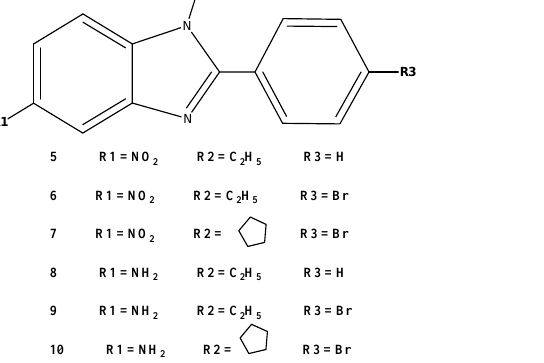
Figure 1. Chemical structures of chemical compound synthesized